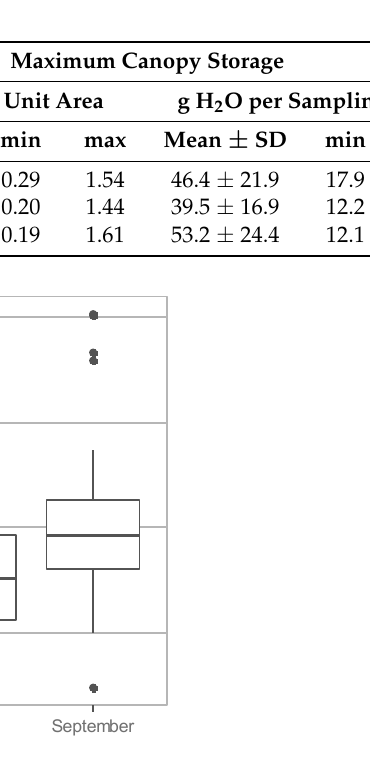
Figure 5. Mean perennial values of meteorological elements and slope of the trend (for whole year and for only growing season) were calculated, and the results are summarized in Table 2. Apart from precipitation and number of days with precipitation in the growing season, all elements show slightly growing trends which are significant ( p -value ≤ 0.05). The non-parametric Mann–Kendall trend test was also performed, using the Kendall R package [51]. Results are compared in Table 2 and it shows the same trends as the linear trends.